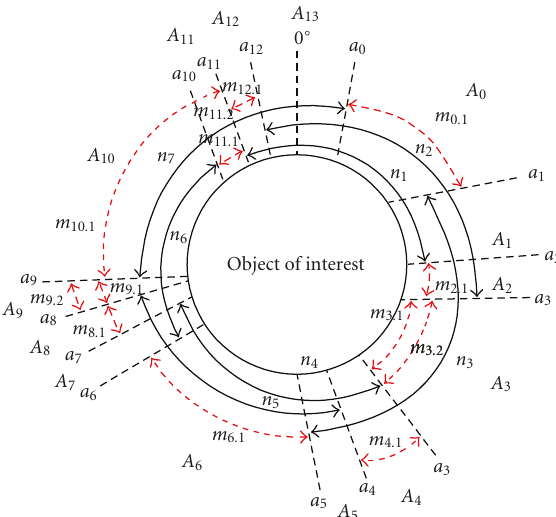
Figure 9: Example of the constructed set of sensors S from G